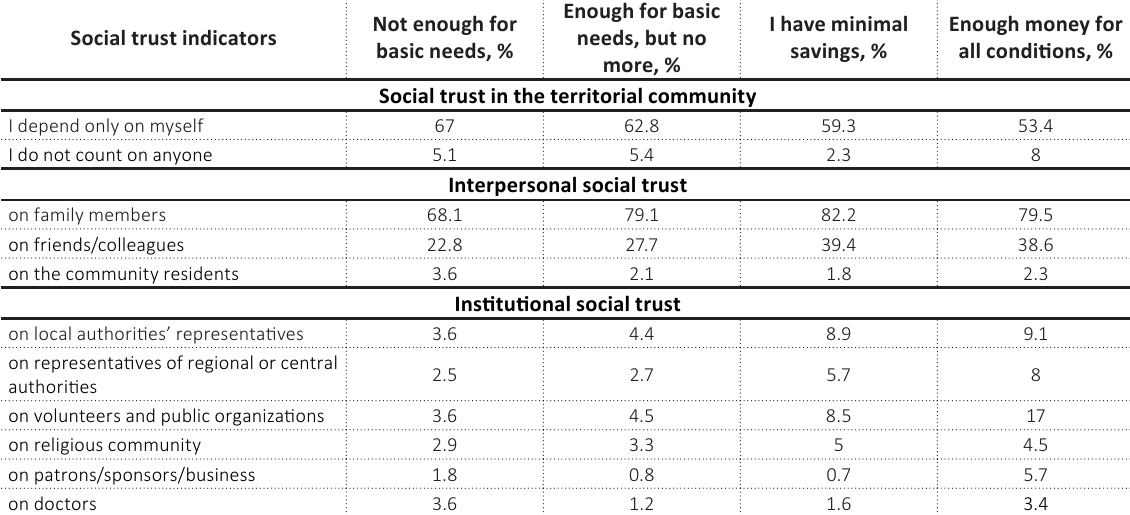
Table 2. Indicators of interpersonal and institutional social trust between people in selected territorial communities (in the context of respondents’ assessments of their socio-economic development) Social trust